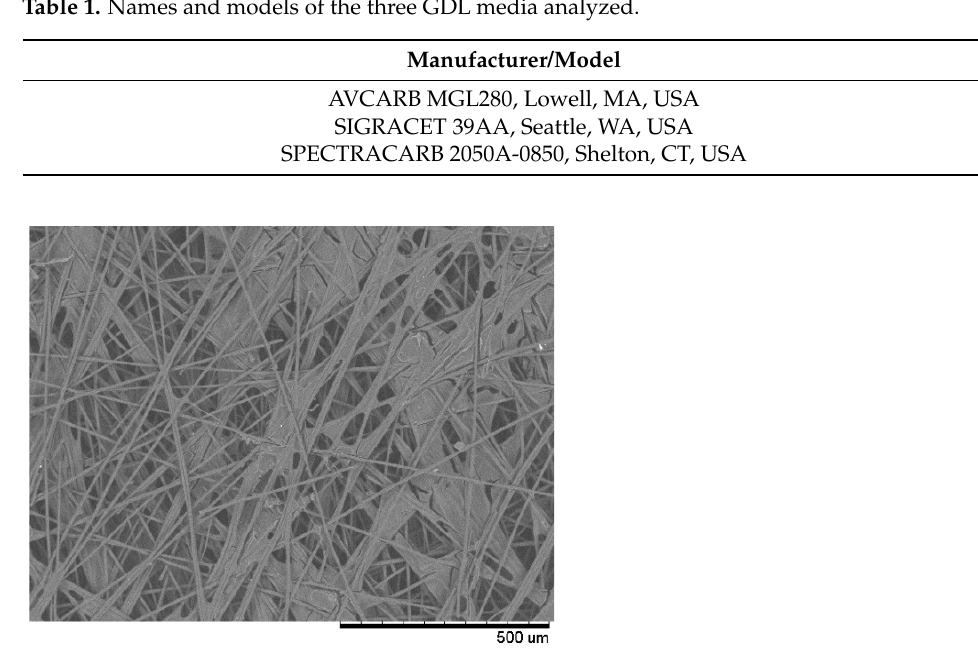
Table 1. Names and models of the three GDL media analyzed.